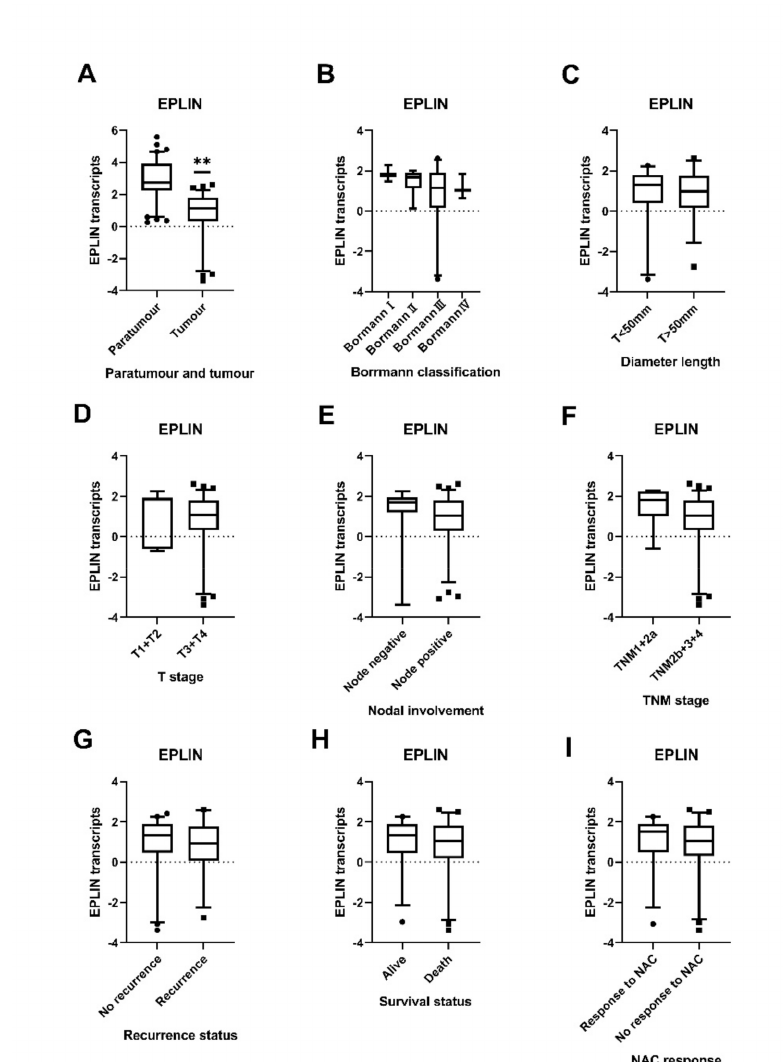
Figure 4. Correlation between EPLIN transcripts and clinicopathology information in gastric can- cer with NAC. ( A ) EPLIN expression was significantly decreased in tumour tissues compared to paratumour tissues. ( B ) A downward trend of EPLIN expression was observed from BorrmannI to BorrmannIV. ( C ) Tumours with diameter length > 50 mm had a lower EPLIN expression compared to that with diameter length < 50 mm group. ( D ): EPLIN expression was expressed at a higher level in the combined T1 + T2 group compared to combined T3 + T4 group. ( E ): EPLIN expression was increased in the node negative group compared to that in node positive group. ( F ): EPLIN expression with earlier stage TNM1+2a was higher than those with advanced stage TNM2b+3+4. ( G ): EPLIN expression was higher in no recurrence group compared to those in recurrence group. ( H ): EPLIN expression in the alive survival group was increased compared to those in the death group. ( I ): Higher levels of EPLIN expression was noted in tumours with response to NAC group than those with no response to NAC group. Shown as median log 10 values with 95% cl. ** p <